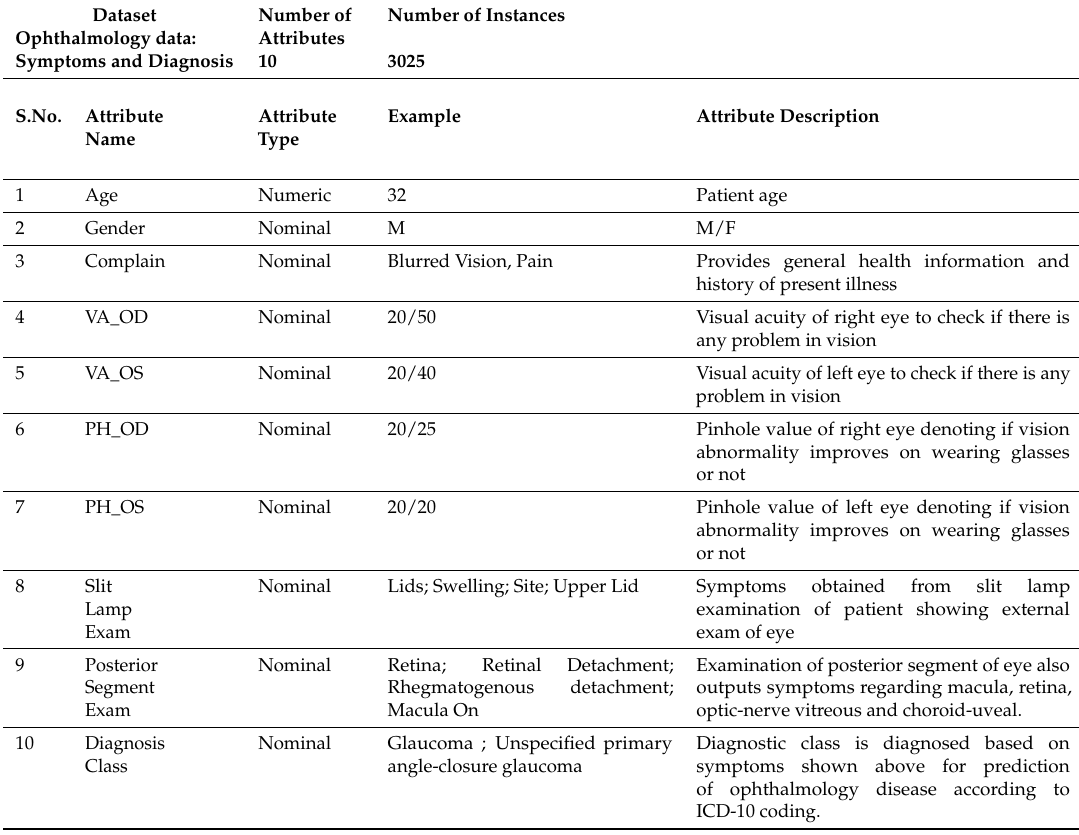
Table 3. Dataset and attributes